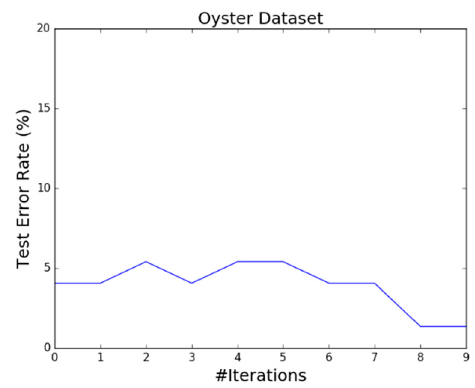
Figure 12. Classification performance over the course of the learning process.